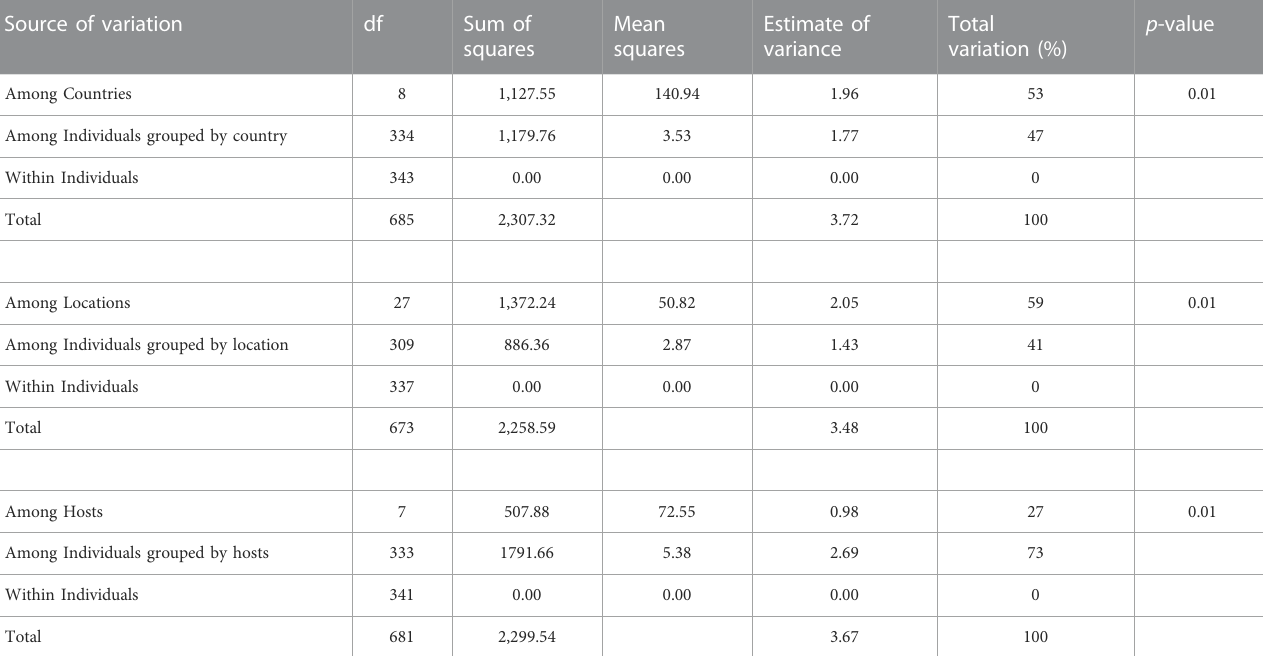
TABLE 2 Hierarchical analysis of molecular variance (AMOVA) of Dothistroma pini populations, grouped by countries, by locations and by host species. Source of variation df Sum of Mean squares